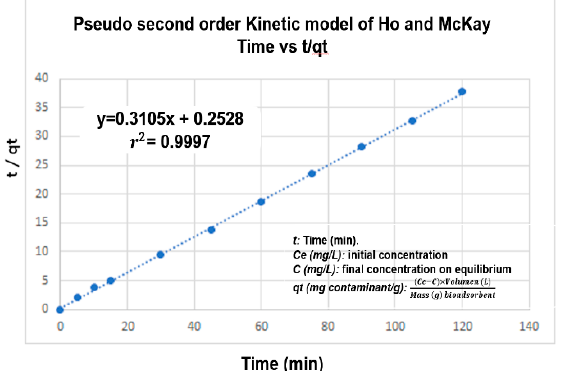
Figure 7. Adsorption kinetics for Zn(II) with CP.